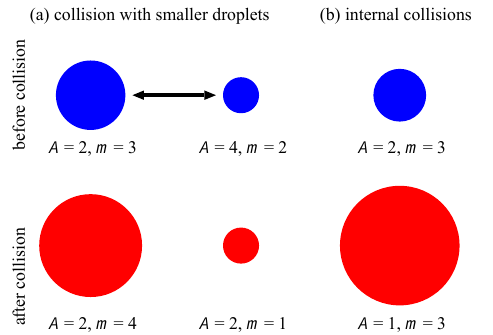
Figure 7. Illustration of (a) the collision of a super-droplet with a super-droplet smaller in radius and (b) internal collisions of a sin- gle super-droplet. Blue (red) circles indicate super-droplets before (after) collision. Weighting factor ( A ) and bulk mass ( m ) are de- noted in arbitrary units. The radius of the colored circle indicates the volume-averaged radius of droplets represented by the super- droplet.